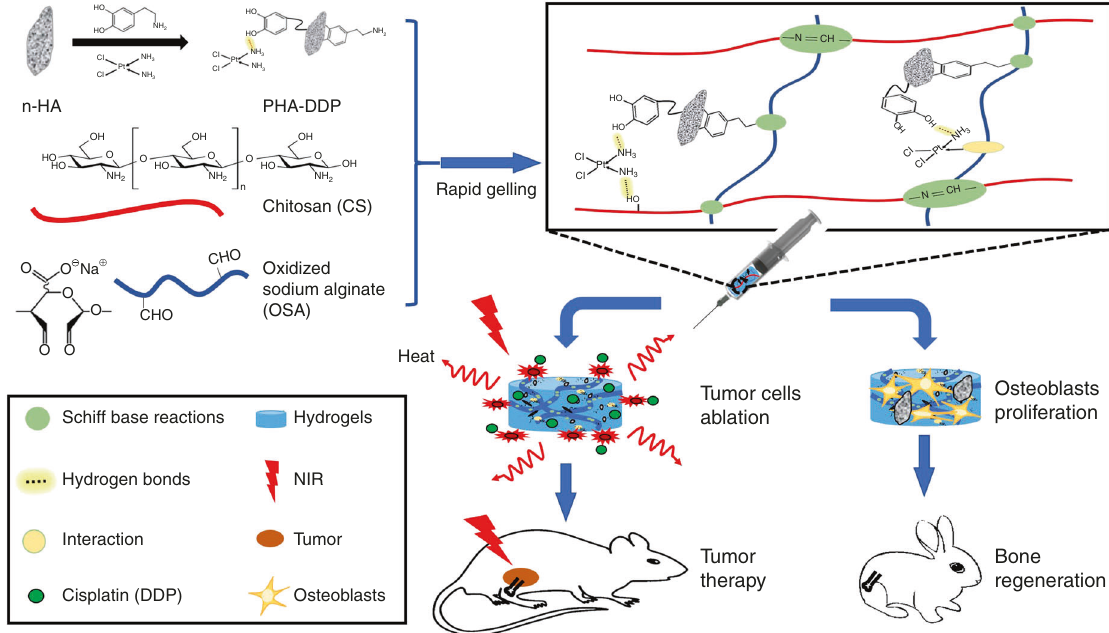
Fig. 4 The formation of a bifunctional OSA-CS-PHA-DDP hydrogel and its bioapplication in tumor therapy and bone regeneration. Reprinted with permission from ref. 136 © 2019,